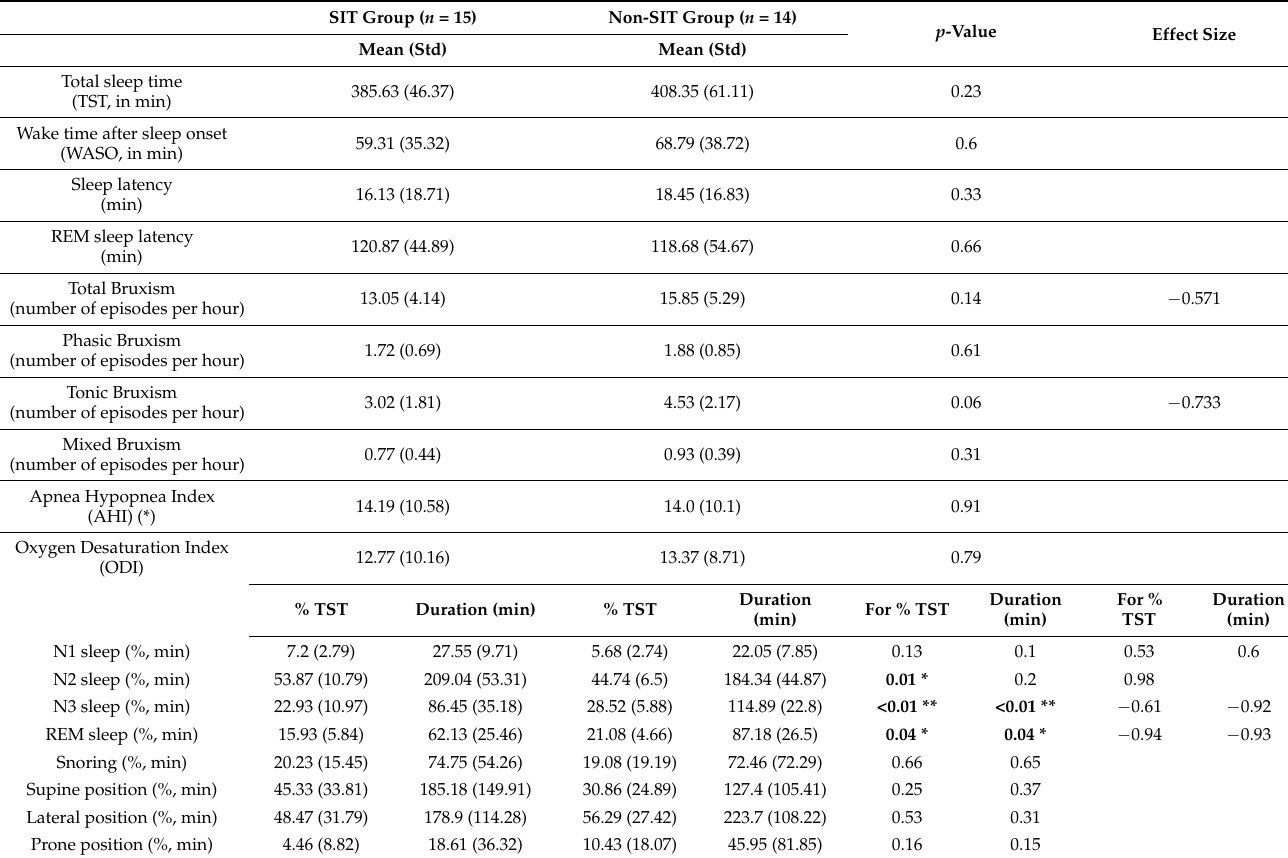
Table 2. Sleep characteristics